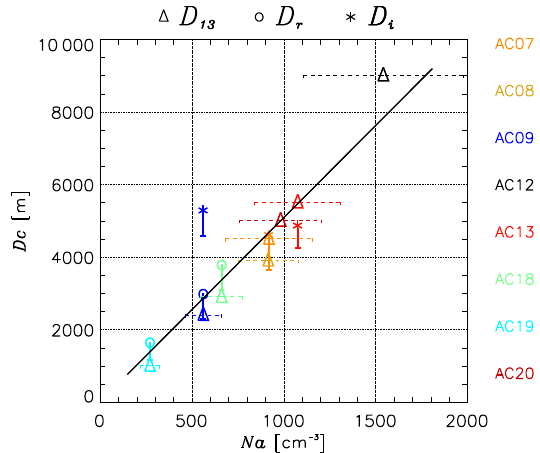
Figure 15. Cloud depth ( D c ) as a function of the estimated adi- abatic number of droplets ( N a ) at cloud base. The D c values for adiabatic cloud droplet effective radius ( r ea ) equal 13µm (or D 13 ) and are indicated by triangles. Similar for cloud depth of rain ini- tiation ( D r ) (indicated by circles) and cloud depth for ice initiation ( D i ) (indicated by an asterisk). The flight numbers are indicated by colors on the right side of the panel. The values of D 13 , D r , and D i are shown in Table 1. The uncertainties of N a estimates are shown by horizontal error bars. The vertical error bars indicate the cloud depth between D r and D r − 1 or D i and D i − 1 . The black line indi- cates the linear equation for D 13 as a function of N a for all flights, where D r = (5 ± 1 . 06 )N a